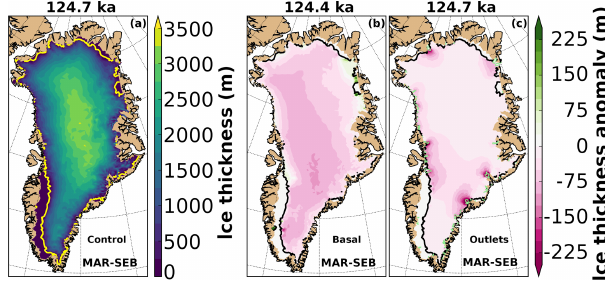
Figure 8. Ice thickness of the control experiment (a) , the basal × 0 . 9 ( b ; reduced friction of the entire ice sheet), and the out- lets × 0 . 5 ( c ; reduced friction at outlet glaciers) experiments at their respective ice sheet minimum (time indicated at the top of the pan- els). Anomalies are relative to the control experiment. The ice mar- gin is indicated with a solid yellow/black line (10m ice thickness remaining). A nonvisible ice margin is identical to the domain mar- gin. The outlet regions are indicated with bright green contours (c) .